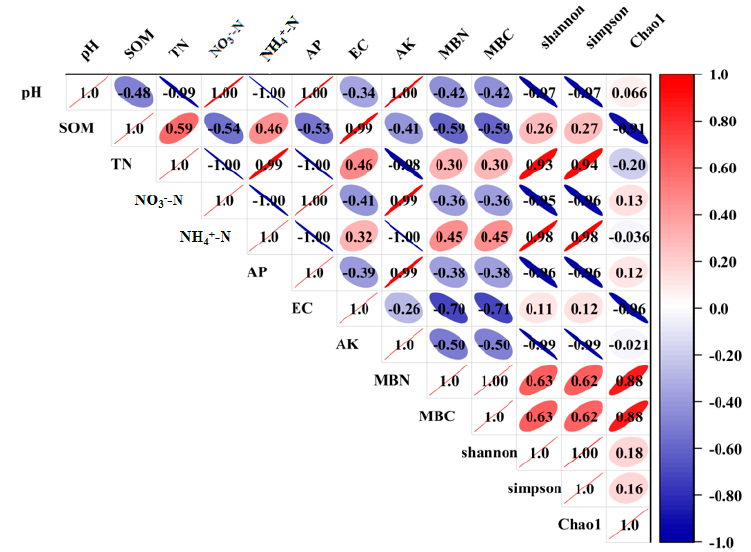
Figure 6. Pearson correlation heat map of soil physicochemical properties and ECM fungal diversity. Red is positive, blue is negative; the darker color means the correlation is stronger.